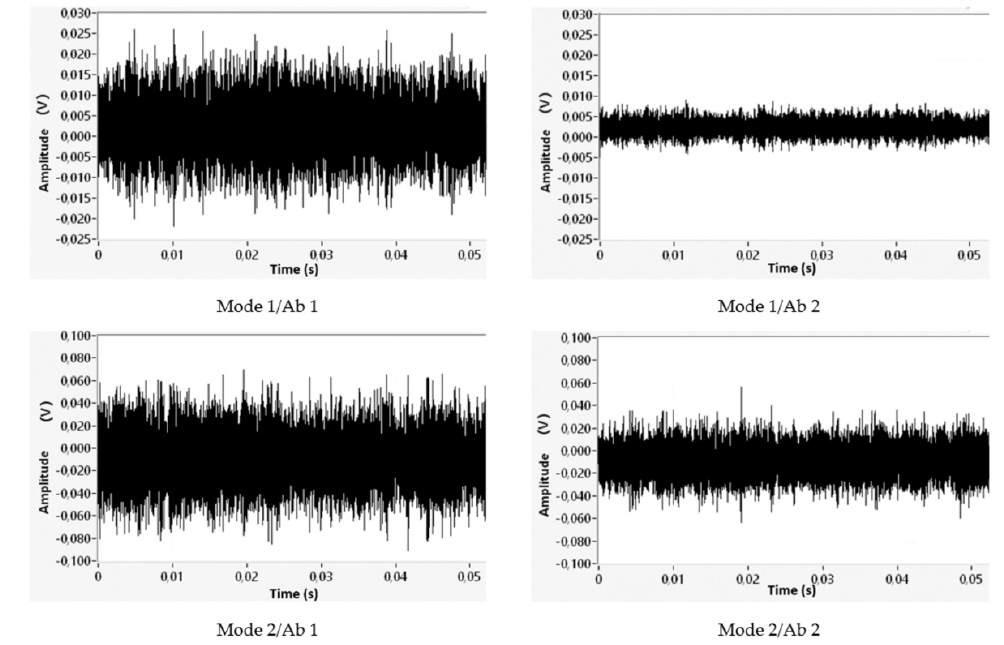
Figure 8. Time records of acoustic emission.